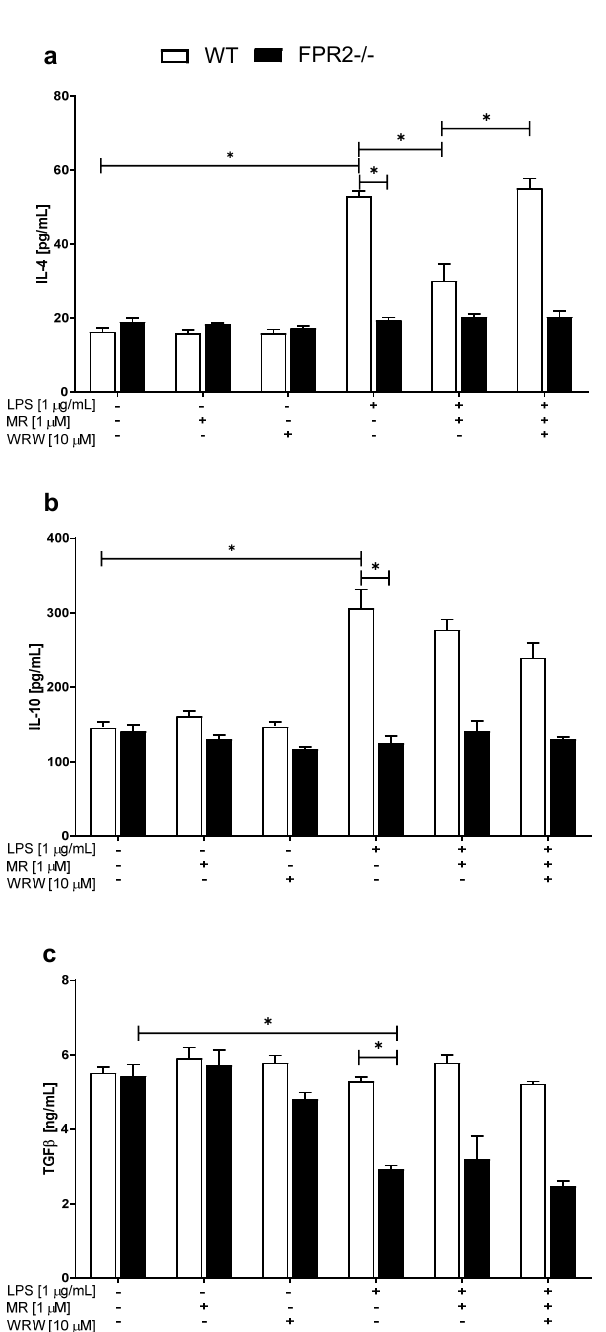
Figure 4. The effects of MR-39 and WRW4 on LPS-evoked anti-inflammatory cytokine ( a —IL- 4; b —IL-10; c —TGF- β ) release in organotypic hippocampal cultures (OHCs) obtained from the offspring of wild-type (WT) and FPR2 − / − (KO) mice. OHCs obtained from WT and KO mice were pretreated with the FPR2 antagonist WRW4 (10 µ M) for 30 min. Afterward, MR-39 (1 µ M) was added and incubated for 1 h, and then OHCs were stimulated with lipopolysaccharide (LPS; 1 µ g/mL) for 24 h. Control cultures were treated with the appropriate vehicle. The results are presented as the means ± SEM. The data were derived from three independent experiments. The results were statistically evaluated using a factorial analysis of variance (ANOVA) with Duncan’s post hoc test to assess the differences between the treatment groups. Significant differences are indicated by * p < 0.05. IL—interleukin; TGF- β —transforming growth factor β . +—with LPS, MR or WRW treatment; —-without LPS, MR or WRW